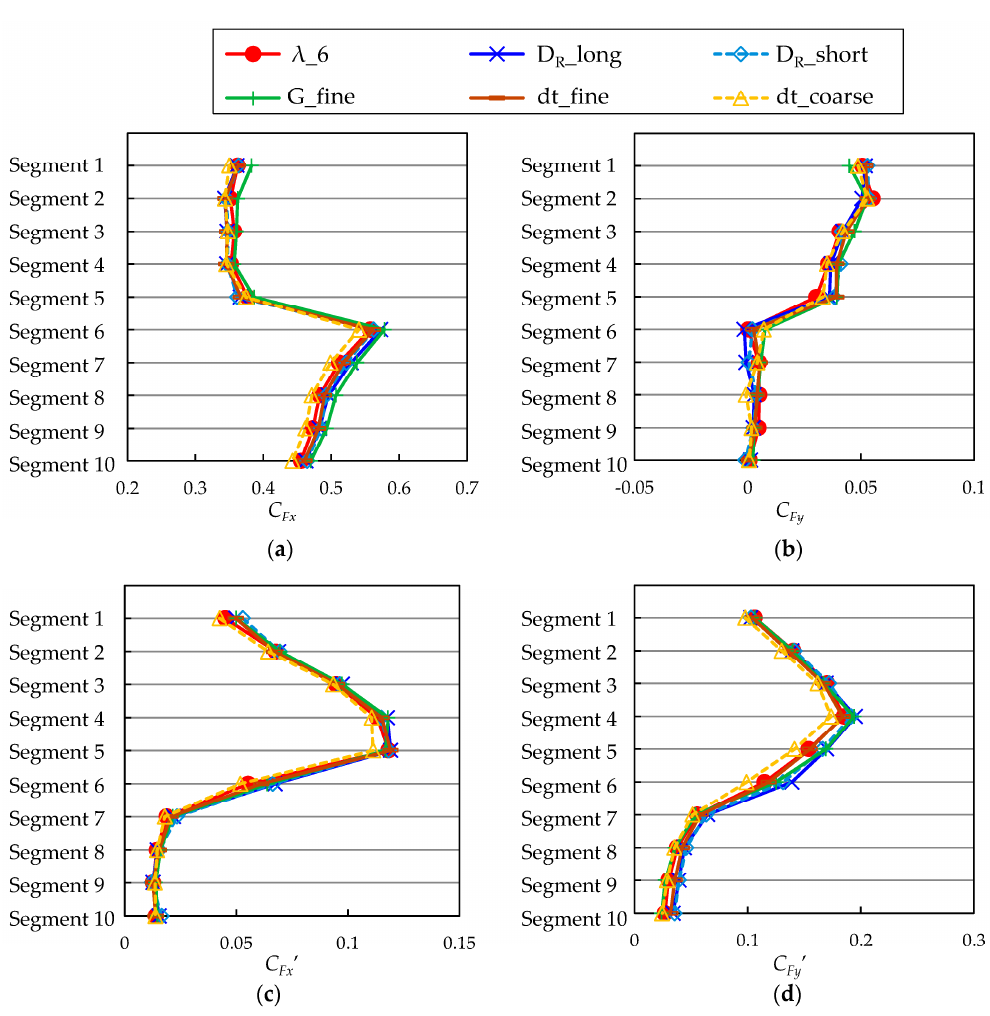
Figure 5. Sensitivity of D R , the grid resolution near tower, and dt on vertical distributions of the mean and fluctuating drag and lift coefficients of each tower segment at λ = 6. ( a ) Mean drag coefficient; ( b ) mean lift coefficient; ( c ) fluctuating drag coefficient; and ( d ) fluctuating lift coefficient.